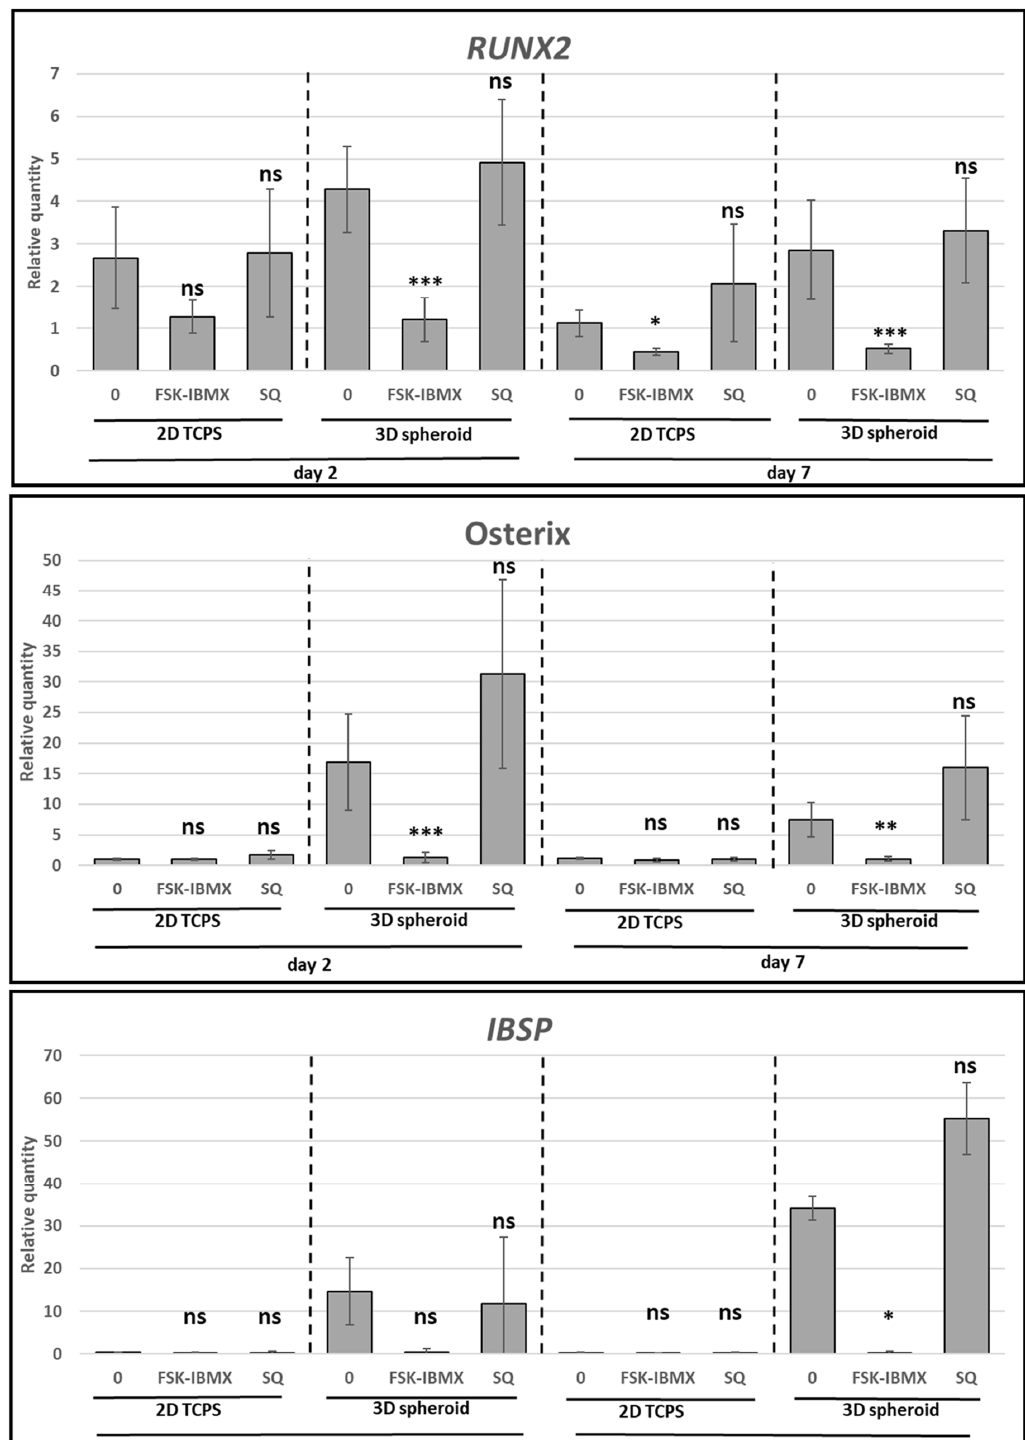
Figure 6. E ff ect of cAMP pathway regulation on osteogenesis—expression of preosteoblast characteristic Figure 6. Effect of cAMP pathway regulation on osteogenesis—expression of preosteoblast genes. ADSCs di ff erentiated for 7 days on 2D TCPS or in 3D spheroids in osteogenic medium (0), characteristic genes. ADSCs differentiated for 7 days on 2D TCPS or in 3D spheroids in osteogenic optionallycontainingFSK–IBMX(FSK,10nM;IBMX,500nM)orSQ22,536(SQ,100nM).Gene-expression medium (0), optionally containing FSK–IBMX (FSK, 10 nM; IBMX, 500 nM) or SQ 22,536 (SQ, 100nM). analysis performed on Days 2 and 7. Presented data are mean from three experiments; each experiment Gene-expression analysis performed on Days 2 and 7. Presented data are mean from three was performed on cells isolated from a di ff erent donor. Error bars represent ± 95% confidence interval. experiments; each experiment was performed on cells isolated from a different donor. Error bars Statistical significance between “0” sample and FSK–IBMX and SQ at the given time point and culture method marked with asterisks: *, p < 0.05; **, p < 0.01; ***, p < 0.001; ns, not